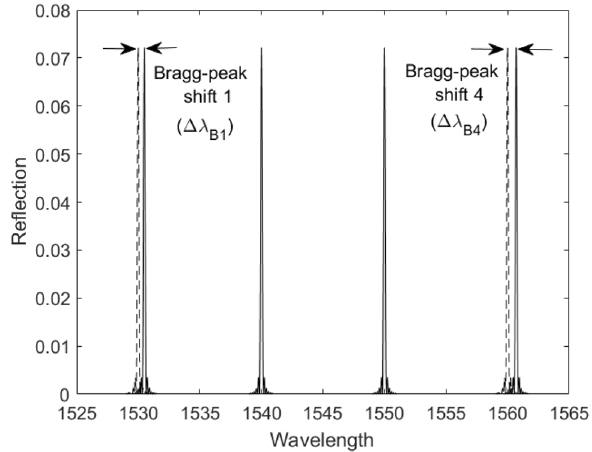
Fig. 2 Bragg shifts Δ 𝜆 B 1 and Δ 𝜆 B 1 of the first and fourth peaks due to the plate undergoing static